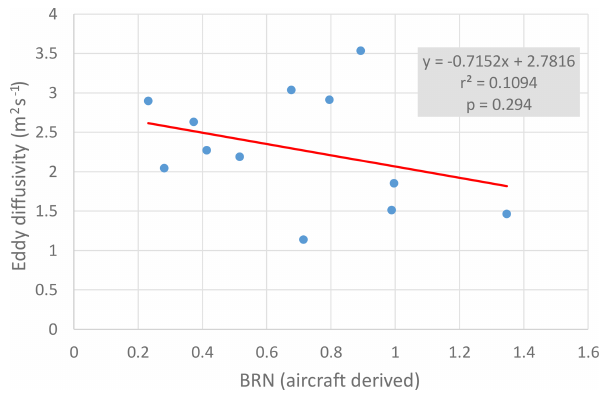
Figure 12. Eddy diffusivities and bulk Richardson numbers (BRNs) derived from aircraft observations.